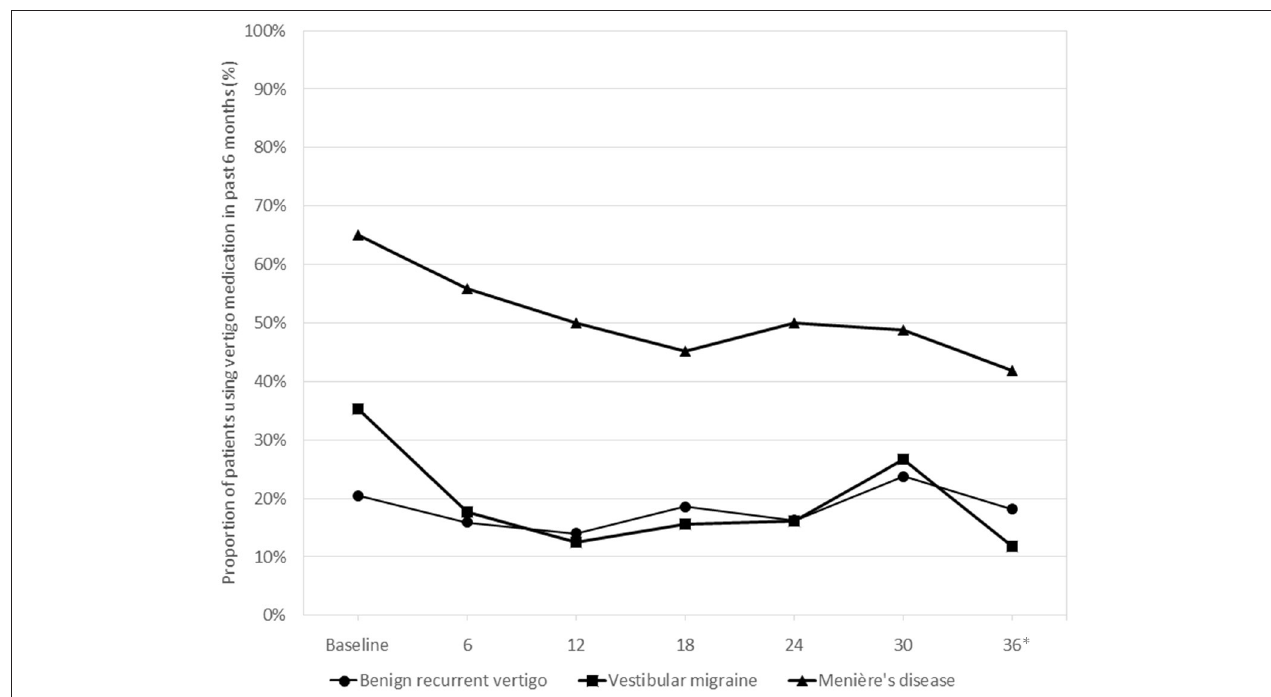
FIGURE 2 | Use of vertigo medication during the 3-year follow-up period in the three diagnosis groups*. *Medication use in the past 6 months was tested at 36 months, the difference between the groups being statistically significant (Chi-square test, p < 0.001).